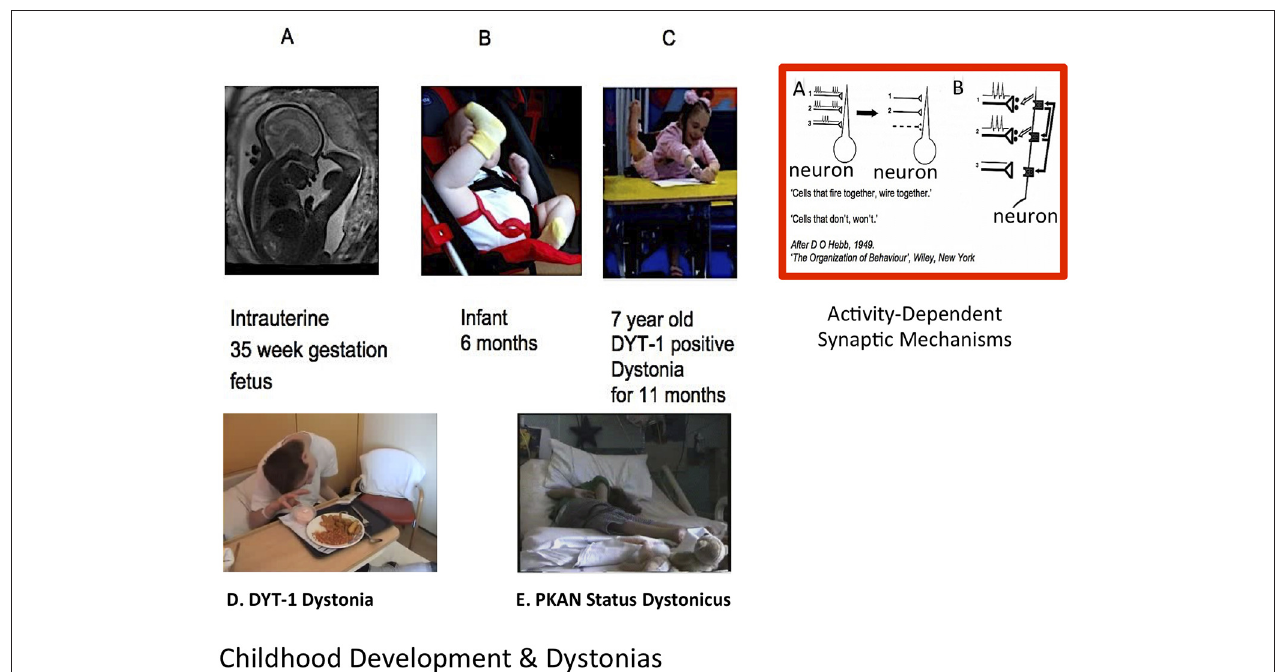
FIGURE 1 | Normal development, dystonia, and role for activity-dependent plasticity. [ Top (L-R)]: Thirty-five week gestation fetus; typically developing 6 month old infant; 7 year old girl with DYT-1 dystonia (2); Red Rectangle: (A) Example of activity-dependent synaptic plasticity. The two synchronously firing neurons (1 and 2) are retained by a “retrograde messenger” from the post-synaptic receptors shown in (B) while the asynchronously firing neuronal connection (3) is lost. From Penn and Shatz (3) annotated from DO Hebb 1949: “The Organisation of Behaviour”. [ Lower (L-R)]: Adolescent with generalized DYT-1 Dystonia attempting to eat; Adolescent